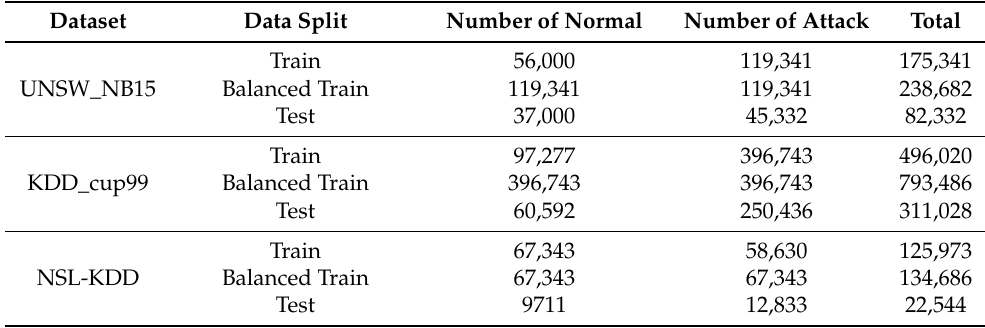
Table 1. Distribution after Data